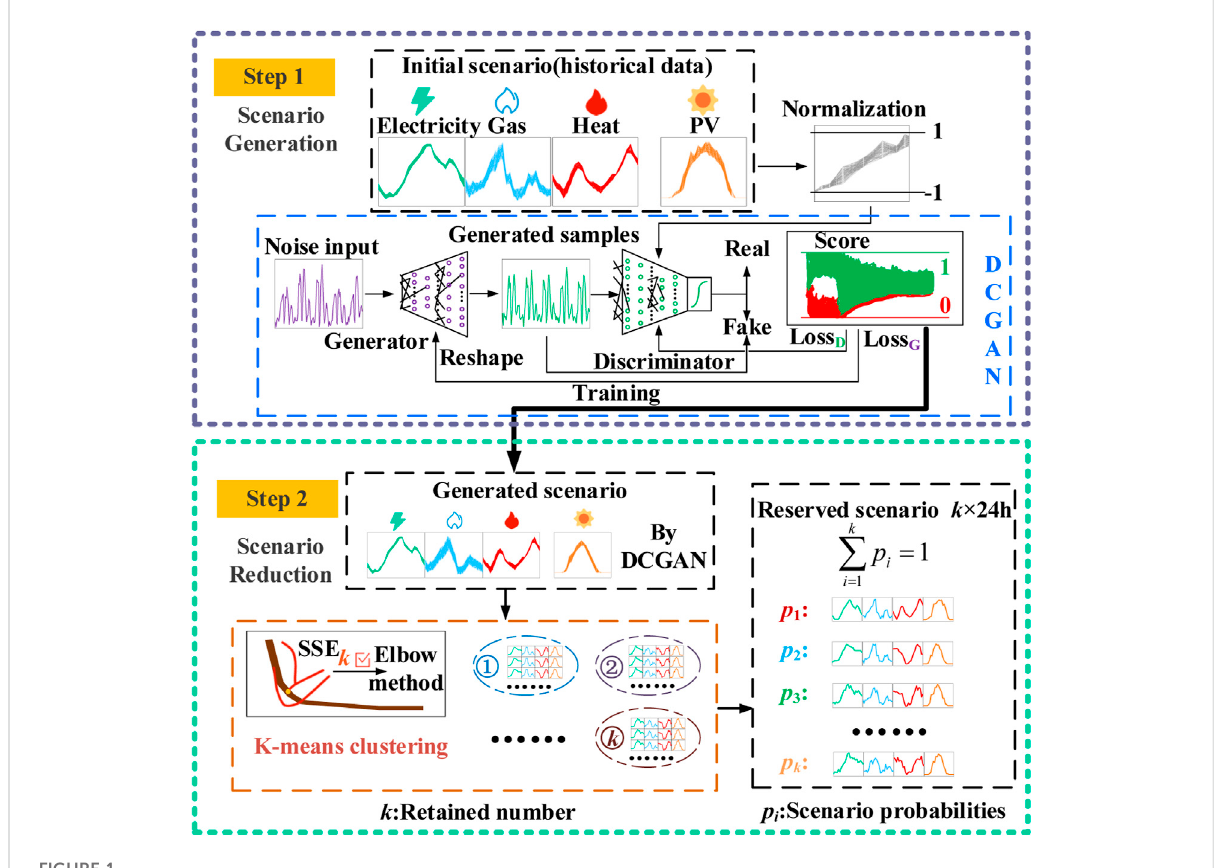
FIGURE 1 The overall fl ow of the two-step containing scenario generation and